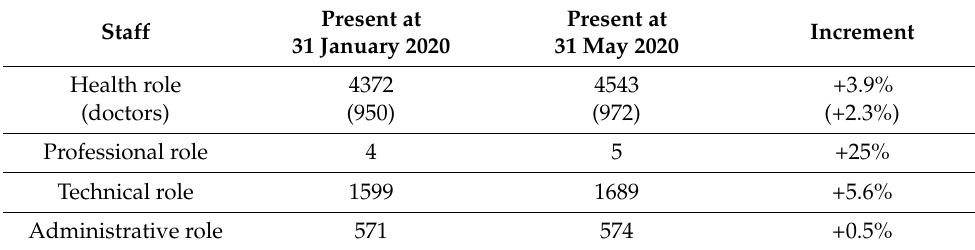
Table 6. Recruitment of staff between February and May 2020. Present at Staff